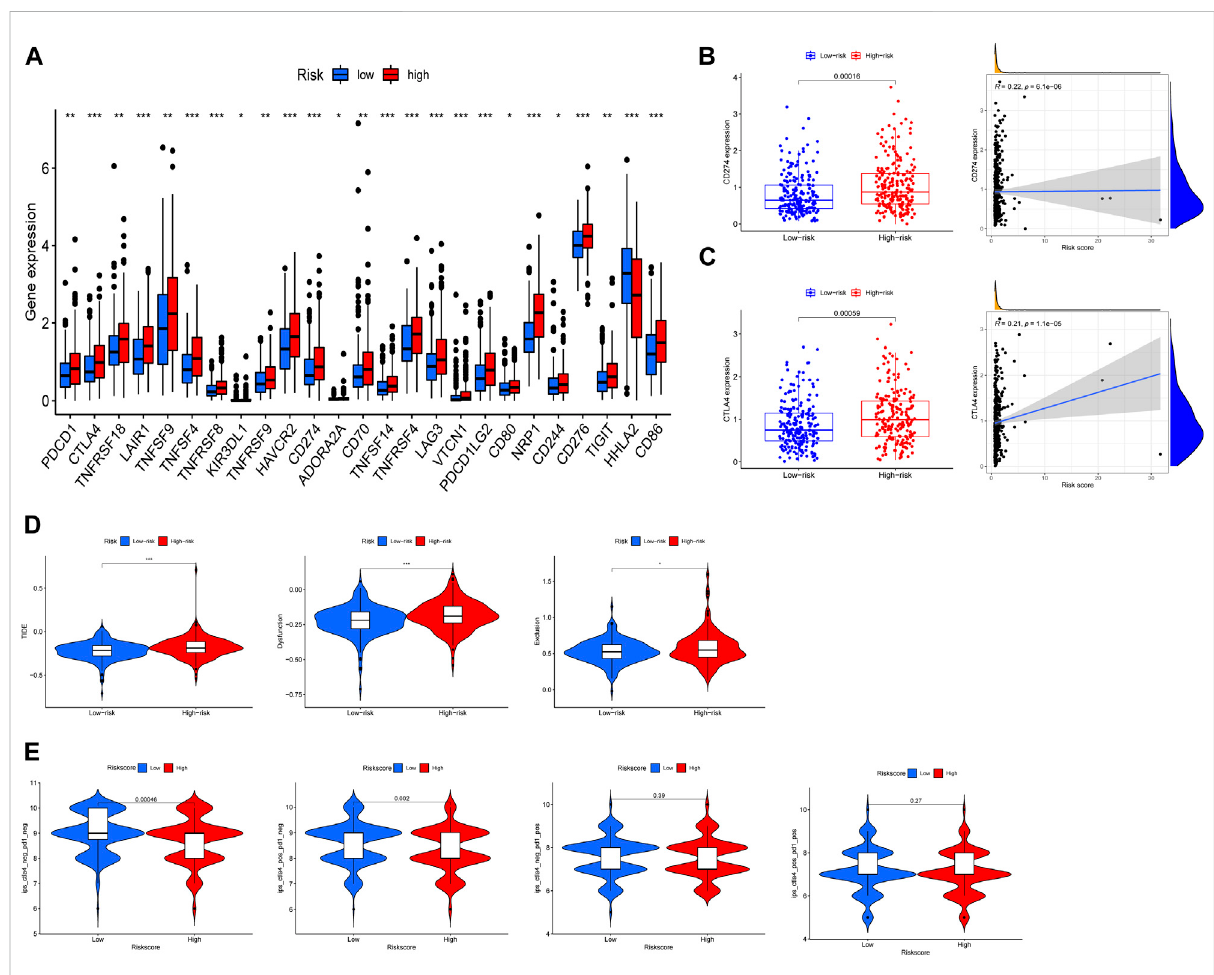
FIGURE 8 Immune checkpoint analysis in high-risk and low-risk groups. (A) The expression of immune checkpoints genes. (B,C) The relation between CD274,CTLA4expressionandriskscore. (D) ThedifferencesofTumorImmuneDysfunctionandExclusion(TIDE)scores. (E) ThedifferencesofIPSin patients with different risk group. * p < 0.05, ** p < 0.01, *** p <